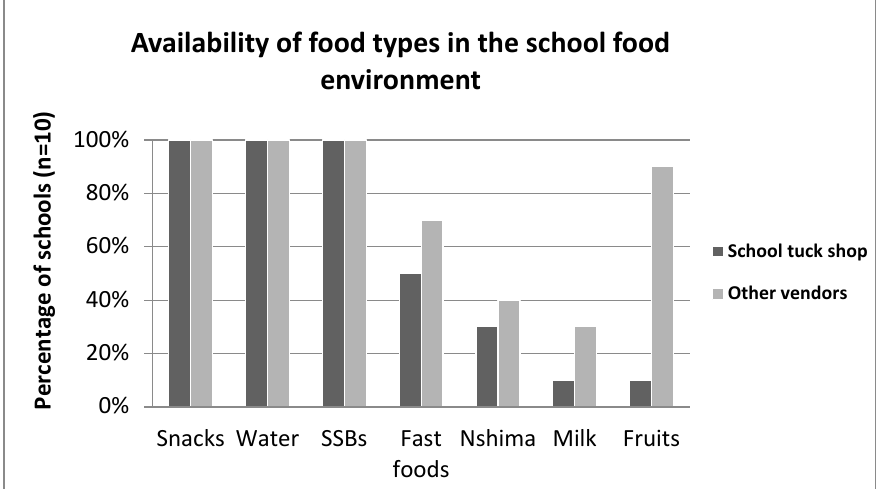
Figure 1. Food availability in the school food environment (Source: School food environment obser- vations).